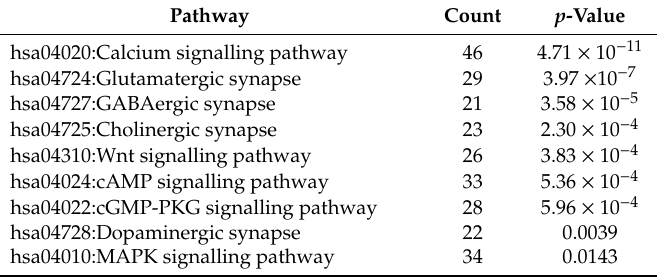
Table 3. KEGG pathway analysis of “pre-lesional” versus PVL transcriptomic datasets.